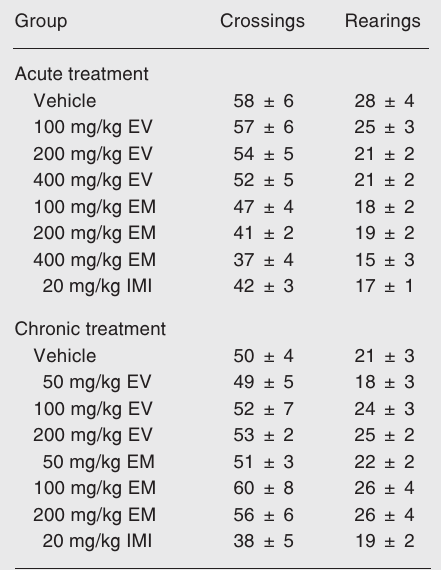
Table 2. Effect of acute and chronic treatment with water-alcohol extract of Erythrina velutina , E. mulungu or imipramine on the locomotor activity of rats submitted to an open field and subse- quently tested in the forced swim